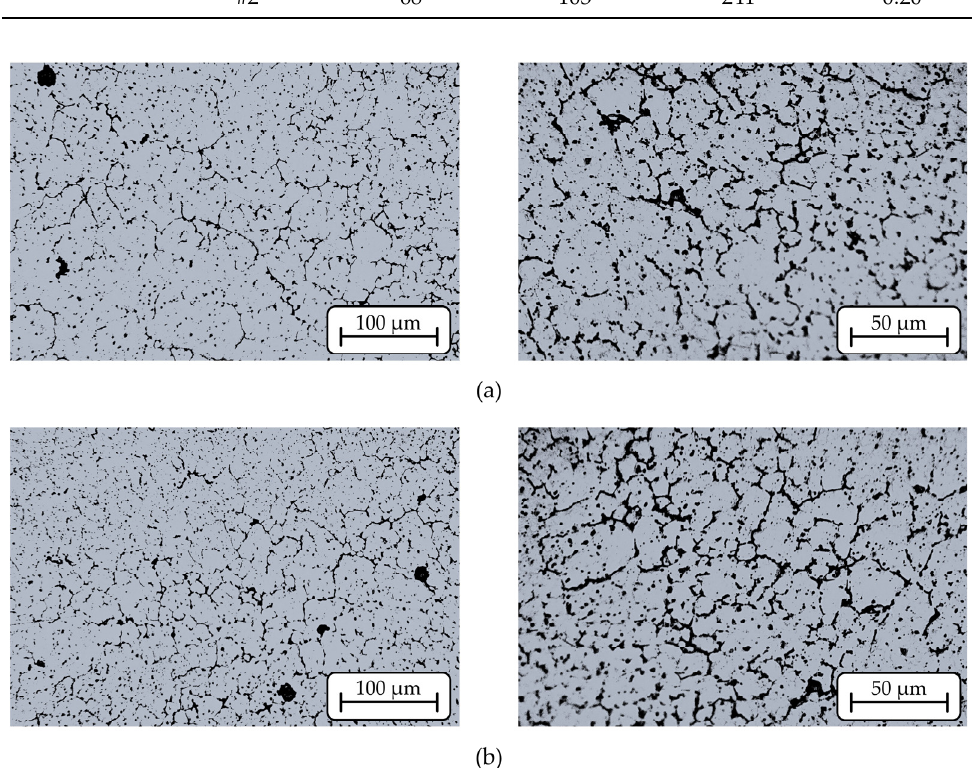
Figure 5. Microstructure of the metallographic samples extracted from deposited ER5356 alumi- num: ( a ) wall set #1 and ( b ) wall set #2. ( a ) wall set #1 and ( b ) wall set